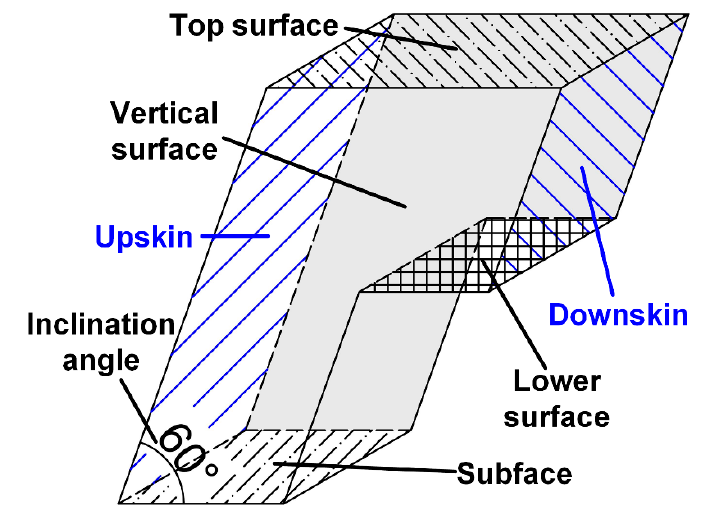
Figure 1. Schematic diagram of different surface types of parts fabricated by selective laser melting